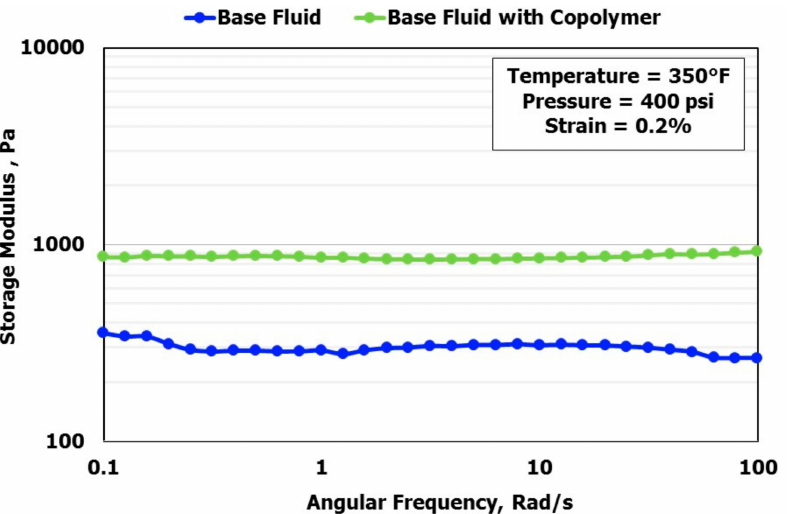
Figure 7. Storage modulus G (cid:48) of the drilling fluid at a temperature of 350 ◦ F, pressure of 400 psi, and a shear strain of